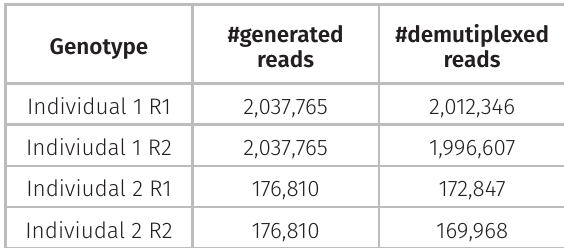
Table I. Generated reads with Miseq Illumina and demultiplexed reads before quality filters. R1: forward reads and R2: reverse reads.